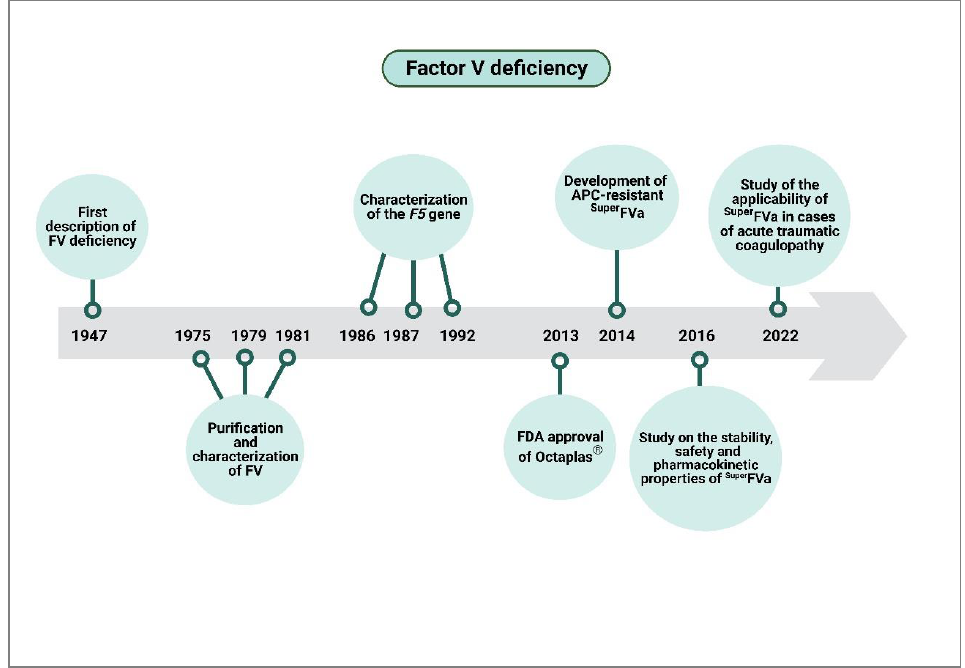
Figure 4. Clinical value chain of factor V deficiency. APC, activated protein C.